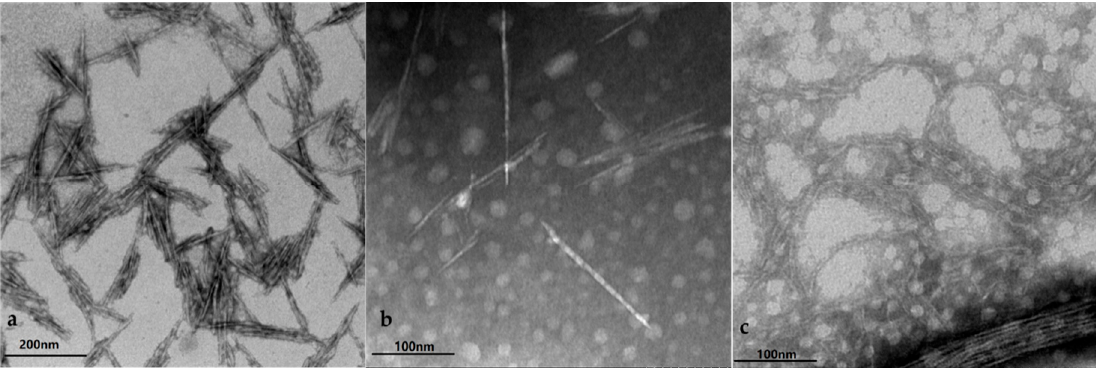
Figure 1. TEM images of CNCs ( a ); CNCs-IBBr ( b ); PMMAZO-grafted CNCs ( c ).